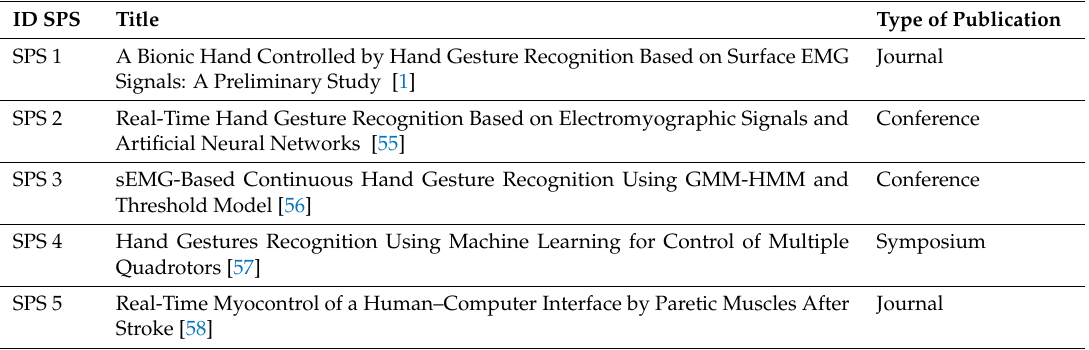
Table 3. The identifier, title, and reference of the 65 selected primary studies (SPS) used in this SLR. ID